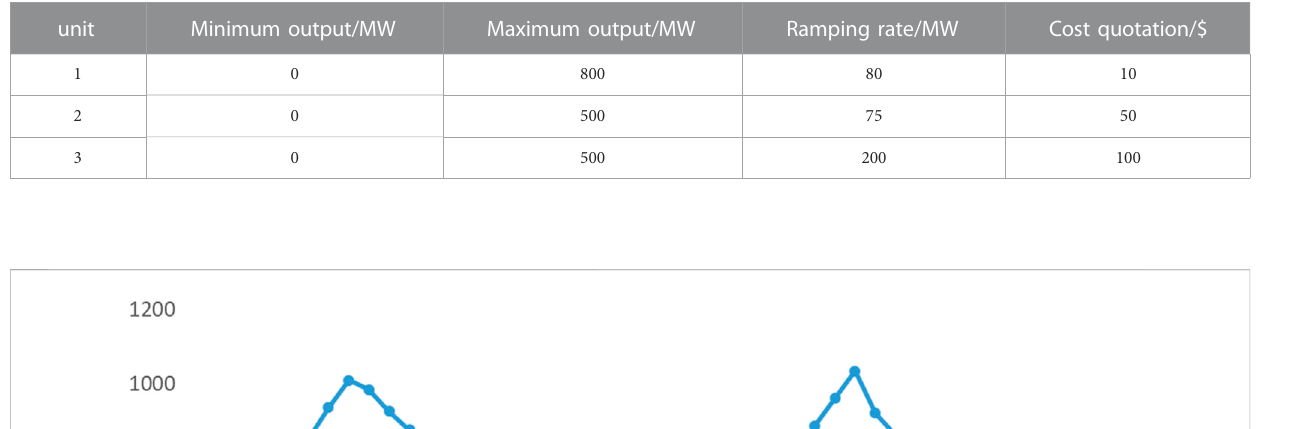
TABLE 1 Technical parameters and cost quotation.